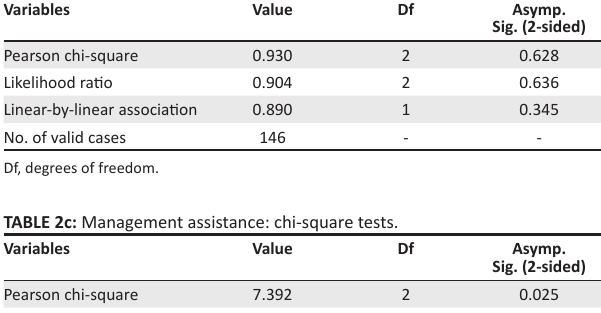
TABLE 1b: Chi-square tests: Export experience and financial management. Variables